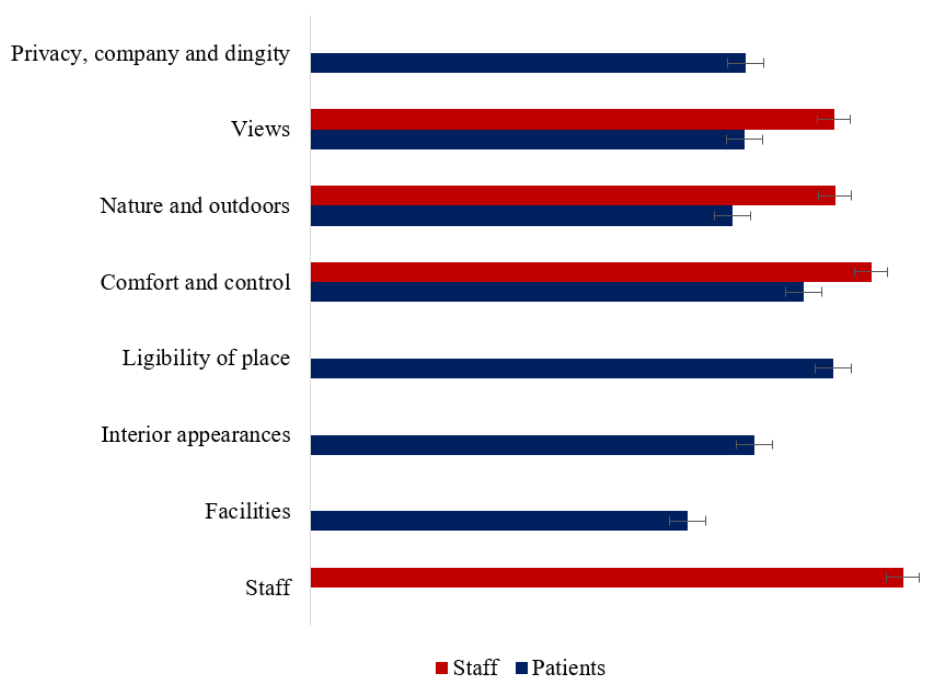
Figure 3. Healing environment for staff and